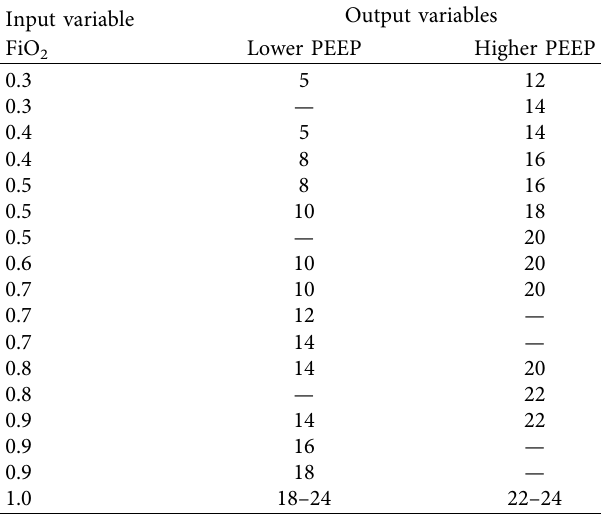
Table 1: ARDS Berlin defnition PEEP adjustments [19,